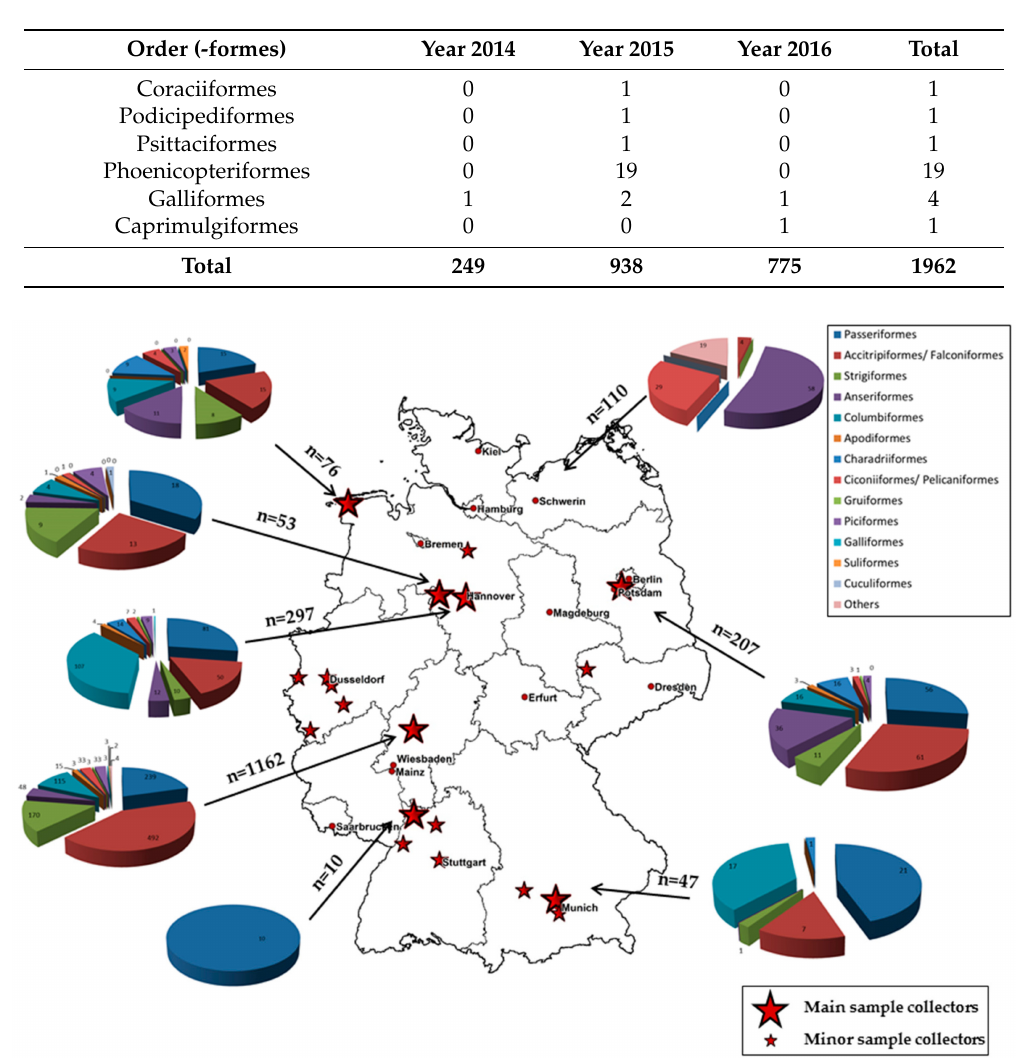
Figure 1. Location of sampling sites with zoological orders of wild bird blood samples from 2014–2016 (big red stars = main collectors, small red stars = minor collectors). The samples highlighted in the pie chart represent the total of all samples collected by all minor and major collectors in each region of